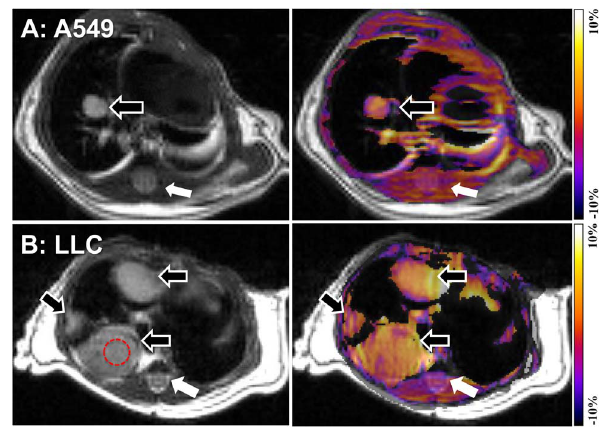
Figure 2. In-vivo APT imaging of lung tumors in the orthotopic mouse model. Representative T2-weighted images (left) and APT- weighted images (right, MTR asym map at 3.5 ppm) of A549 ( A ) and LLC ( B ) where the tumors (open arrows) are delineated brighter than the surrounding tissues including spinal cord (closed arrows) and skeletal muscles. A typical region of interest to measure signal intensity on a tumor is demonstrated ( B ).